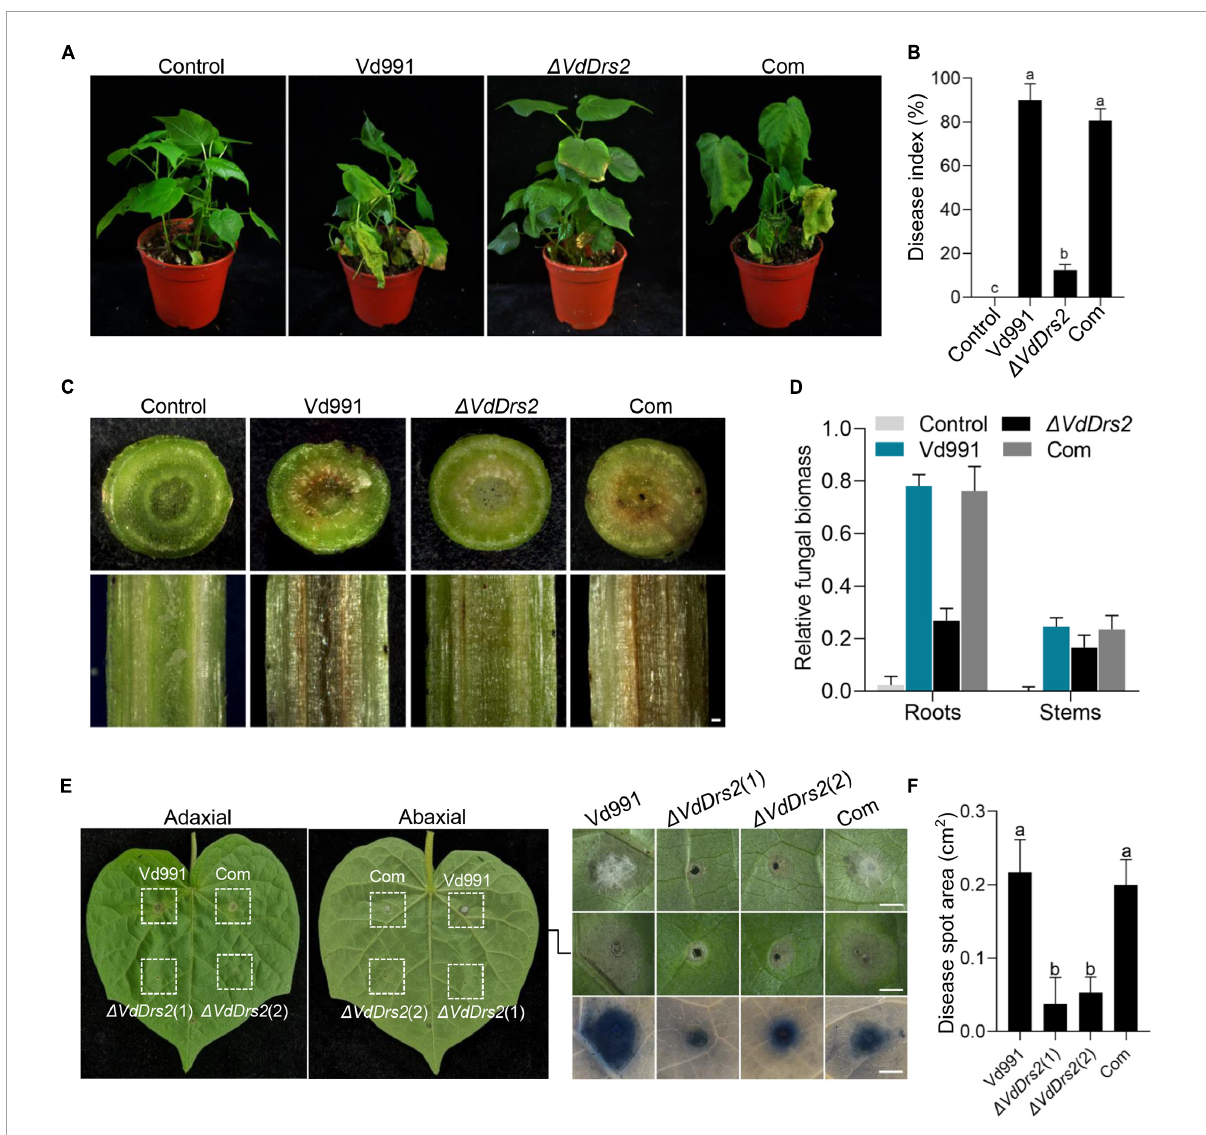
FIGURE2 Knockout of VdDrs2 reduces the pathogenicity of V. dahliae to cotton. (A) Disease symptoms of cotton plants inoculated with spores of Vd991, (cid:49) VdDrs2 , and complemented strains (Com) by root-dipping inoculation. Control, cotton seedlings were inoculated with sterile water; Vd991, (cid:49) VdDrs2 , and Com, seedlings were inoculated with spore suspensions (5 ml, 1 × 10 7 spores/ml) of wild type strain Vd991, (cid:49) VdDrs2 , and Com, respectively. (B) Disease index of infected cotton plants. The grades of disease symptoms are described in the methods. 30 cotton plants were used per treatment. Different letters (a, b, and c) indicate a significant difference ( P < 0.05) based on one-way ANOVA with Tukey multiple comparisons test. (C) Comparison of vascular discoloration associated with VW in cotton plants infected with Vd991, (cid:49) VdDrs2 , and Com strains by root-dipping inoculation. Top, transverse sections of the infected cotton stems; bottom, longitudinal sections of the infected cotton stems. Scale bar represents 0.2 mm. (D) Fungal biomass in cotton plants 14 days post root-dipping inoculation. Fungal biomass was determined by quantitative real-time PCR using ITS1-F and ST-VE1-R primers as described by Ellendorff et al. (2009). Cotton GhUBQ7 served as an endogenous plant control. (E) Disease symptoms of cotton leaves after inoculation with Vd991, (cid:49) VdDrs2 , and Com spores. Each leaf had four injection spots. 5 µ l conidia solution (1 × 10 7 spores/ml) was used for each injection. Left column, adaxial leaves; middle column, abaxial leaves; right column, enlargement, and trypan blue staining of lesion regions in the middle column. Trypan blue staining was used to detect the cytolytic area of the lesion regions (bottom). (cid:49) VdDrs2 (1) and (cid:49) VdDrs2 (2) are technical replicates. Scale bars represent 0.2 cm. (F) Statistics of lesion area on the leaves inoculated with Vd991, (cid:49) VdDrs2 , and Com.